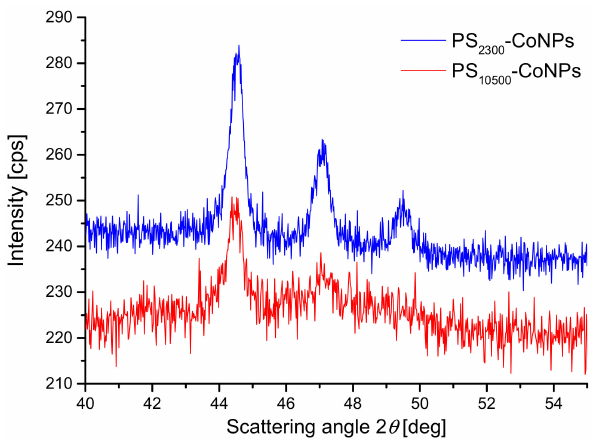
Figure 8. Wide angle X-ray scattering (WAXS) patterns of PS 2300 –Co NPs and PS 10500 –Co